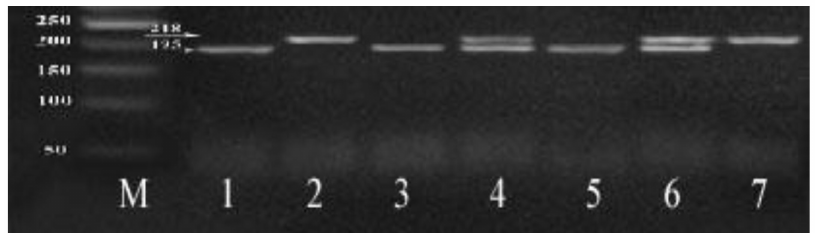
Figure 1. 3% agarose gel for c.1254C > T digested products: 50 bp DNA ladder is in lane M, lanes 2, 7: contain one 218 bp band of T/T genotype, lanes 1, 3, 5: contain 195, 23 bp bands represent C/C genotype. Lanes 4, 6: contain 218, 195 bp bands and 23 bp (not seen) represent the C/T genotype.